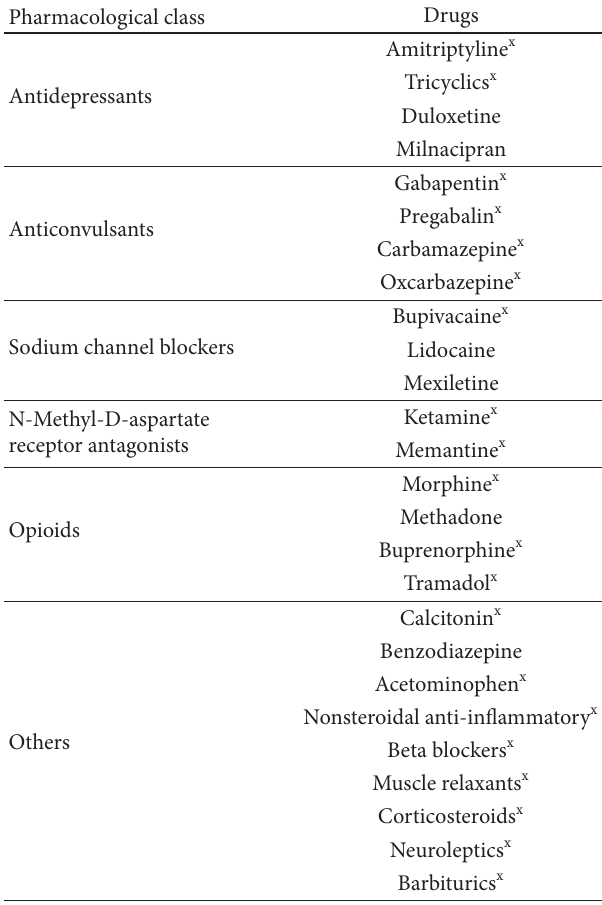
Table 2: Drugs used in the treatment of phantom